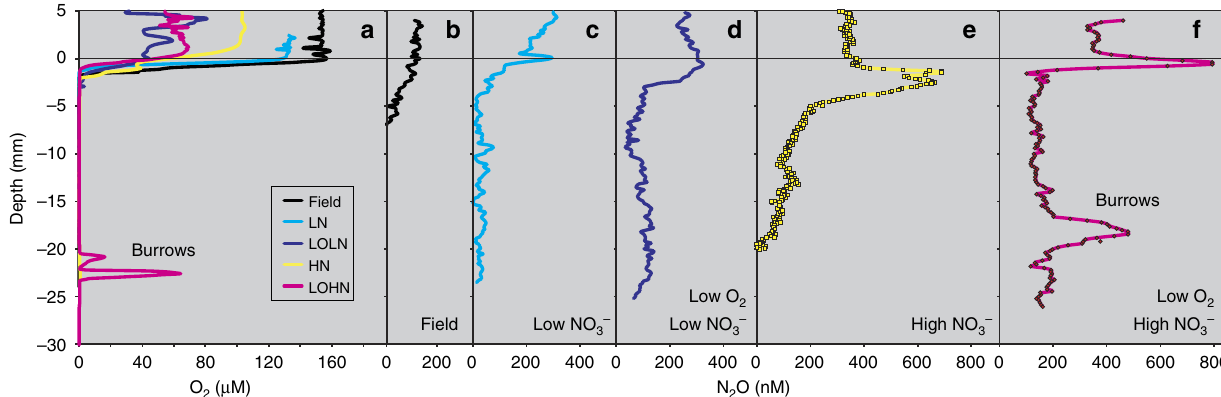
Figure 2 | Example microsensor profiles of O 2 and N 2 O from sediment core incubations from the Mischwatt site illustrating typical heterogeneity observed. Rapid consumption of O 2 in the upper 2–3mm ( a ) reflects the high organic matter content and respiration rates of these sediments. Depth profiles of N 2 O are shown in b through f . ‘Field’ profile ( b ) reflects conditions immediately upon core collection. Profiles from experiment cores reflect porewater conditions after B 7–8 days of incubation under low NO 3 (cid:2) ( c ), low O 2 and low NO 3 (cid:2) ( d ), high NO 3 (cid:2) ( e ) and low O 2 and high NO 3 (cid:2) ( f ). The complexity in the structure of the N 2 O profiles—including subsurface zones of production likely influenced by bioirrigation—complicate their use in conventional flux estimation by porewater